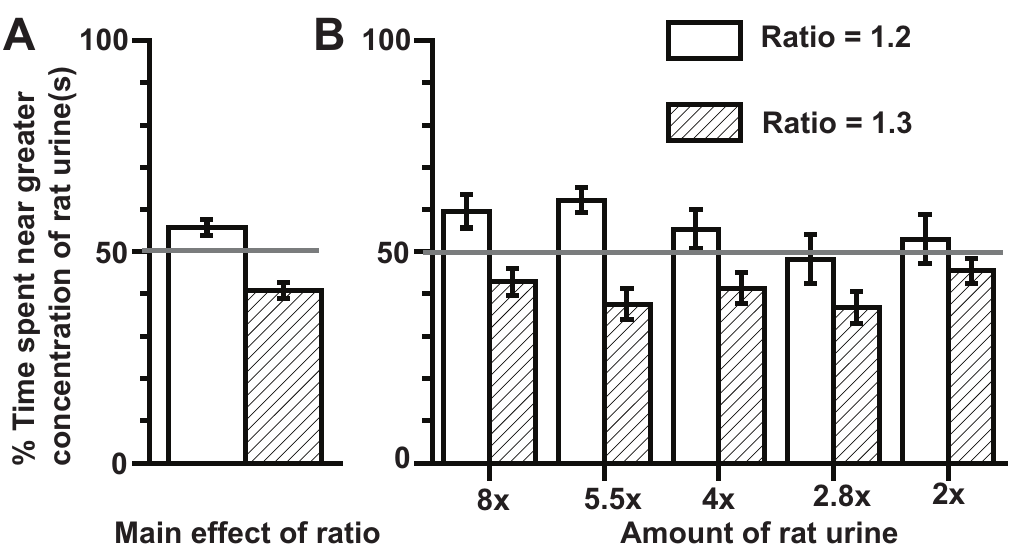
Figure 2. Discrimination threshold in mice is proportional to kairomone strength (mean±SEM). The discrimination threshold at varying doses of rat urine was further examined by setting up an avoidance-avoidance conflict, where mice chose to spend time in arms containing either lower or higher amounts of rat urine. The higher dose was of either a 20% (un-shaded bars) or 30% (shaded bars) greater magnitude (e.g. 120% or 130% of 2X). Abscissa depicts the lower dose used in each of the comparisons (e.g. 2X). Ordinate depicts time spent in arm with the greater amount of rat urine divided by the sum of the time spent in both arms (gray line = 50% chance). N = 15 mice for all comparisons.Log scale; arbitrarily set as 3.125 µl of rat 2